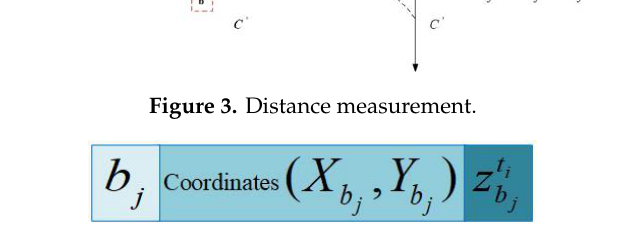
Figure 4. Localization message block from anchor.